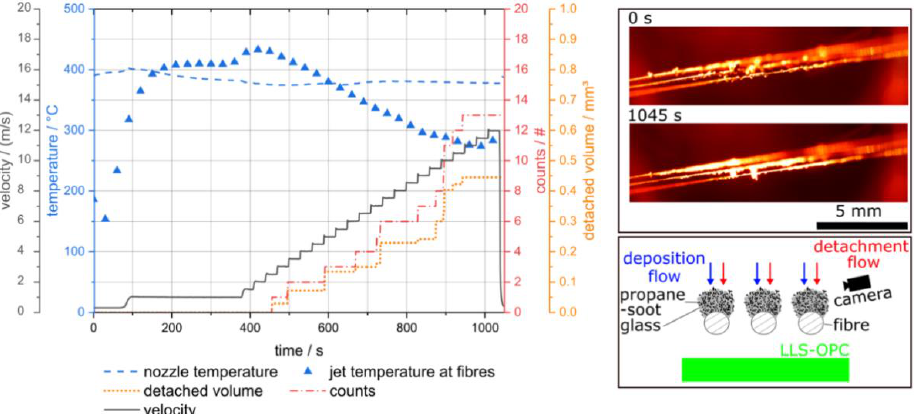
Figure 7. Detachment of soot–glass particle structures from 3 parallel fibres at high temperature and stepwise increasing flow velocity. The left side of the figure show the velocity and temperature con- ditions together with measurement data from the LLS-OPC, and the right side shows images taken by the